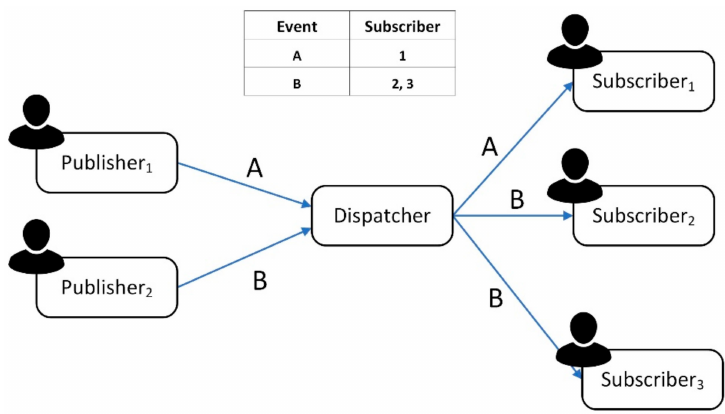
Figure 3. Publish–Subscribe communication scheme.